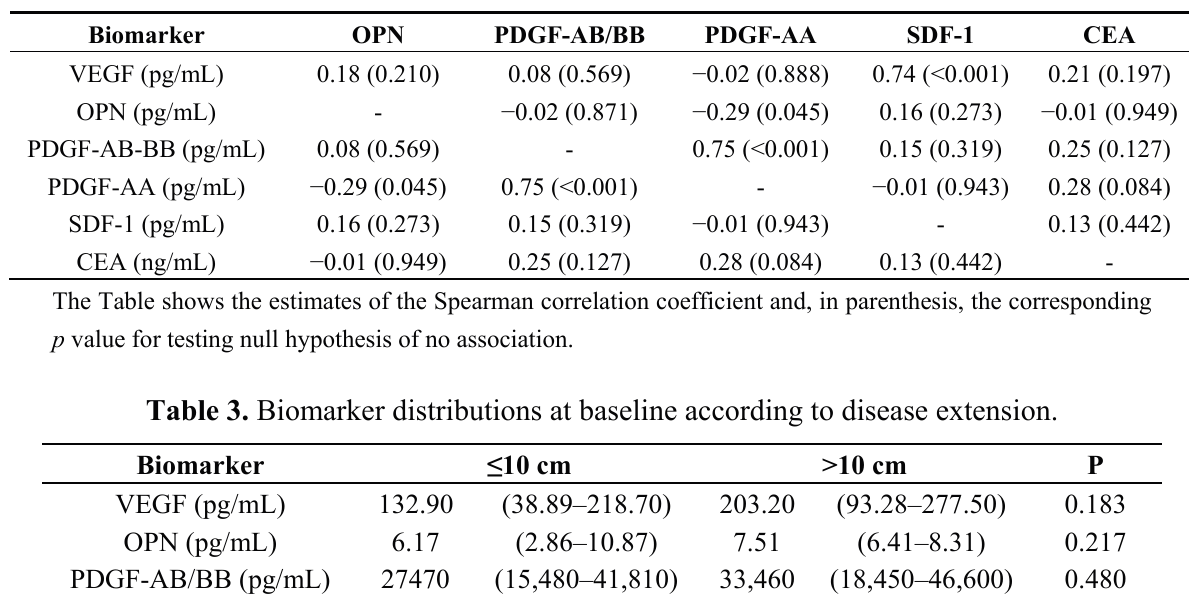
Table 2. Association between biomarker baseline values.